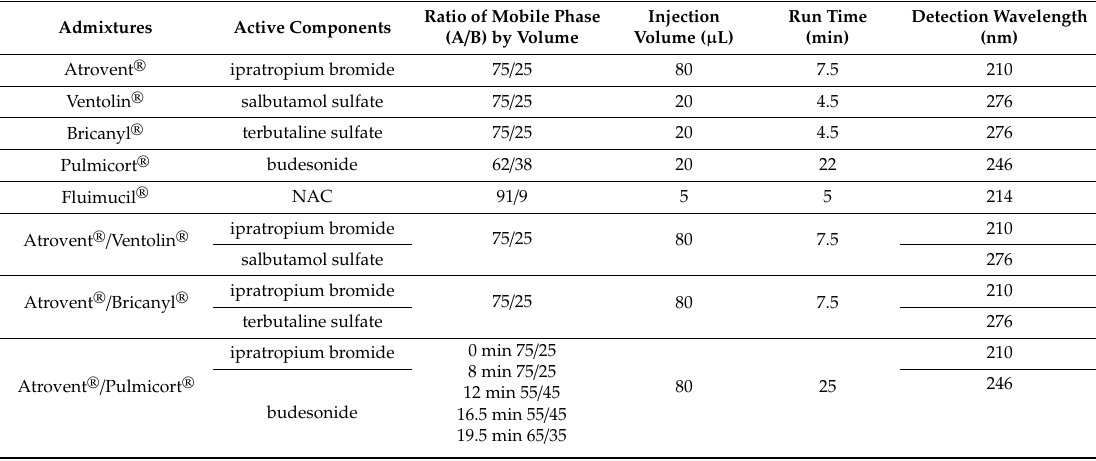
Table 2. Chromatographic